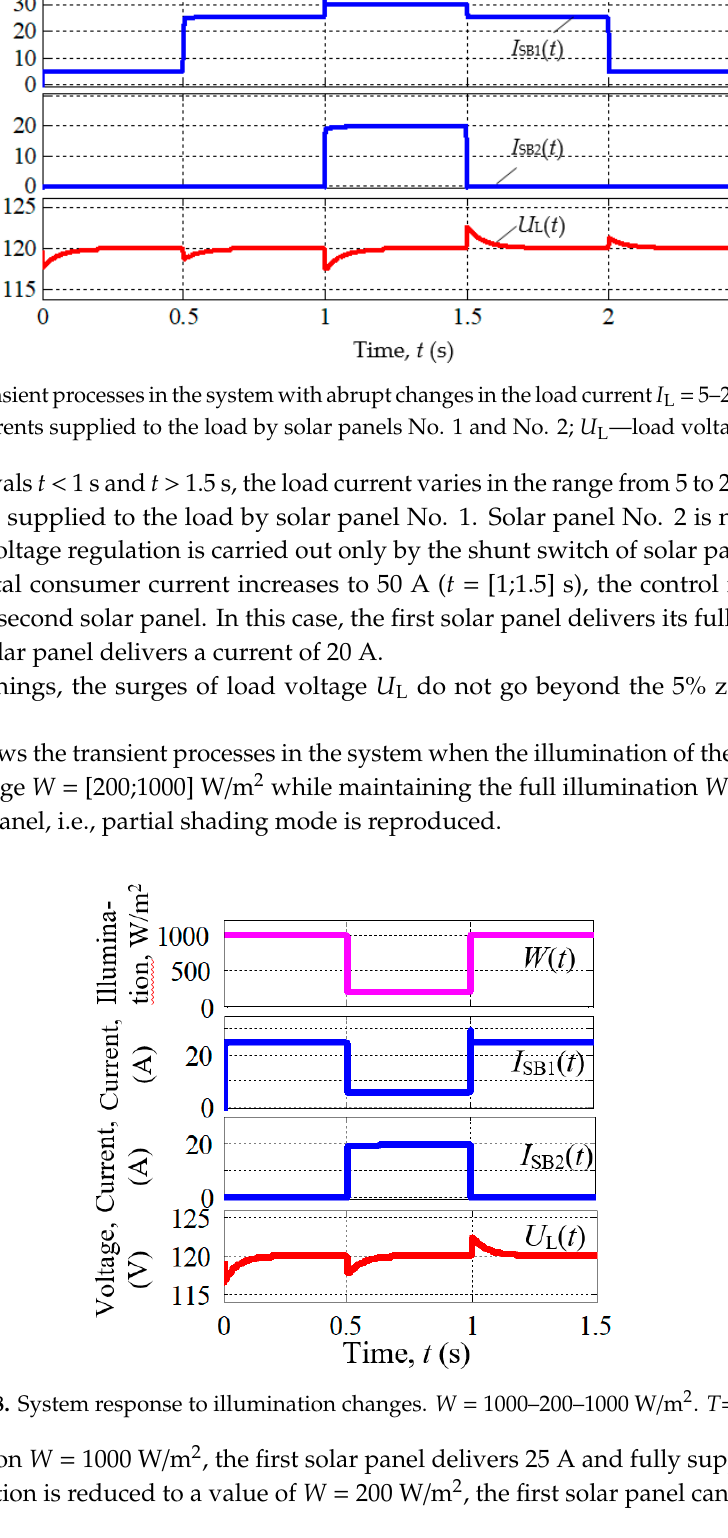
Figure 19. System response to temperature changes. T = ( − 110)–(+80)–( − 110) ° С . W =1000 W/m 2 . Analysis of Figure 19 confirms the automatic transfer of control between the solar panels. At low temperatures, the first solar panel cannot provide the full current I L = 29 A, and the load is distributed across two solar panels, I SB1 ≈ 27 A, I SB2 ≈ 2 A. Thus, an experimental check confirms the system’s performance in a wide range of changes in external disturbing influences. 7. Discussion of the Results Let us evaluate the compliance of the paper results with the goals stated in the introduction. The mathematical model of the solar panel proposed in the paper has confirmed its adequacy and made it possible to carry out the planned studies of the control system on its basis. The model reveals the parametric dependence of the current–voltage characteristics of the solar panel on the luminous flux density and the temperature of the photocells. This made it possible to carry out a quantitative analysis of the operation of the control system in a given range of variation of the indicated values as disturbing influences. The most important result of applying the proposed model is to obtain the dynamic characteristics of a solar panel in the frequency domain. The resonant properties of the solar panel, discovered as a result of the study of these characteristics, made it possible to establish the occurrence of a voltage of reverse polarity on its photocells, which is inadmissible according to the technical operating conditions. This phenomenon is eliminated by choosing the quantization